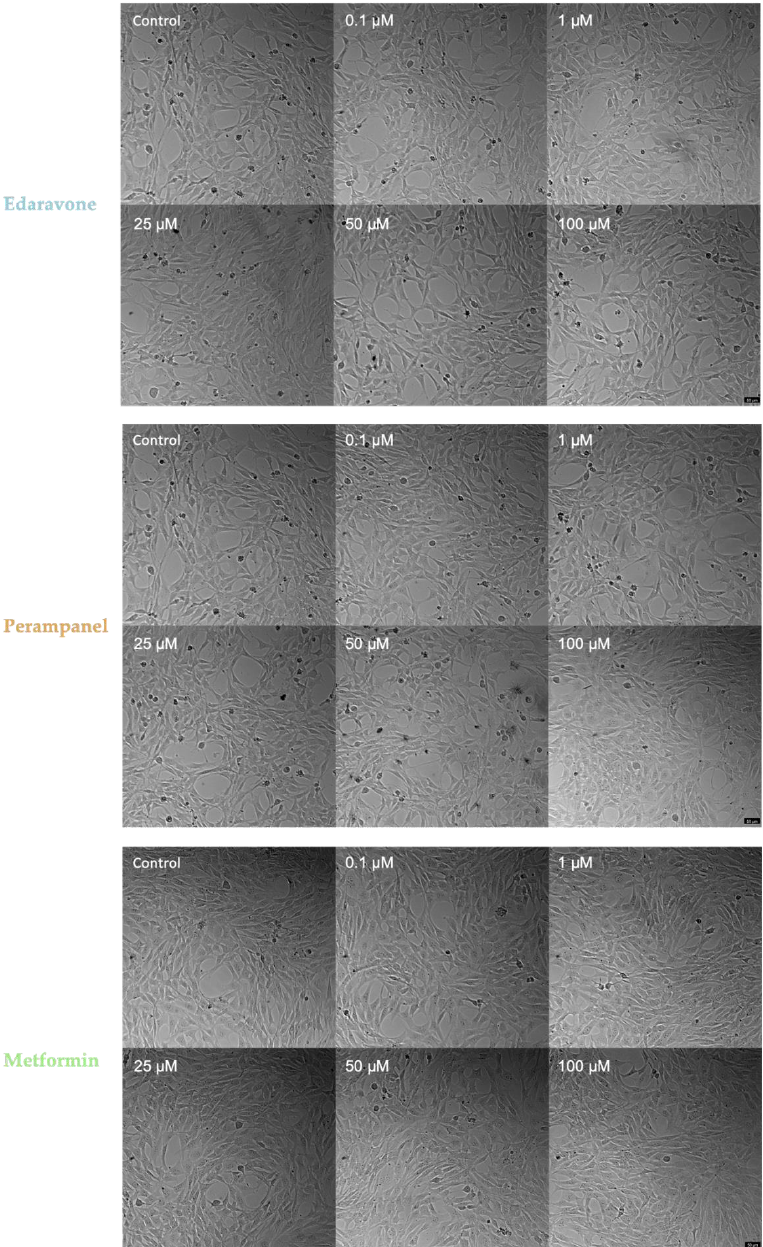
Figure 14. Microscopic representative images of HT-22 oxygen–glucose deprivation (OGD) control cells and HT-22 cells exposed for 6 h to OGD and concentrations, ranging from 0.1 to 100 µM, of edaravone, perampanel, and metformin. Images of cell morphology were obtained using a Leica microscope equipped with Leica LAS X imaging software v3.7.4 (Leica Microsystems, Wetzlar, Germany) from three independent experiments. Scale bar: 50 µm.